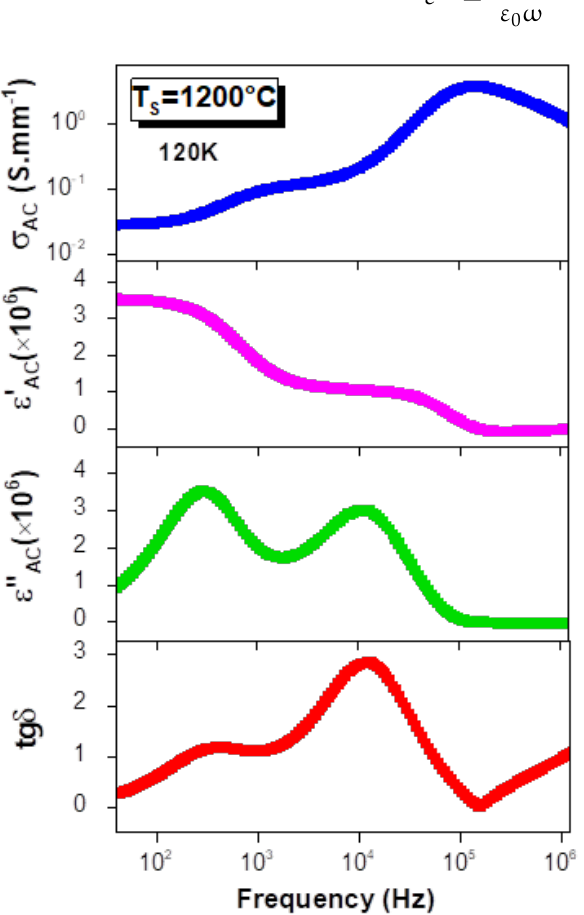
Figure 7. Frequency dependences of AC conductivity, and real and imaginary parts of dielectric permittivity and dielectric loss tangent for the La 0.9 Sr 0.1 MnO 3 compound sintered at 1200 ◦ C and performed at 120 K.